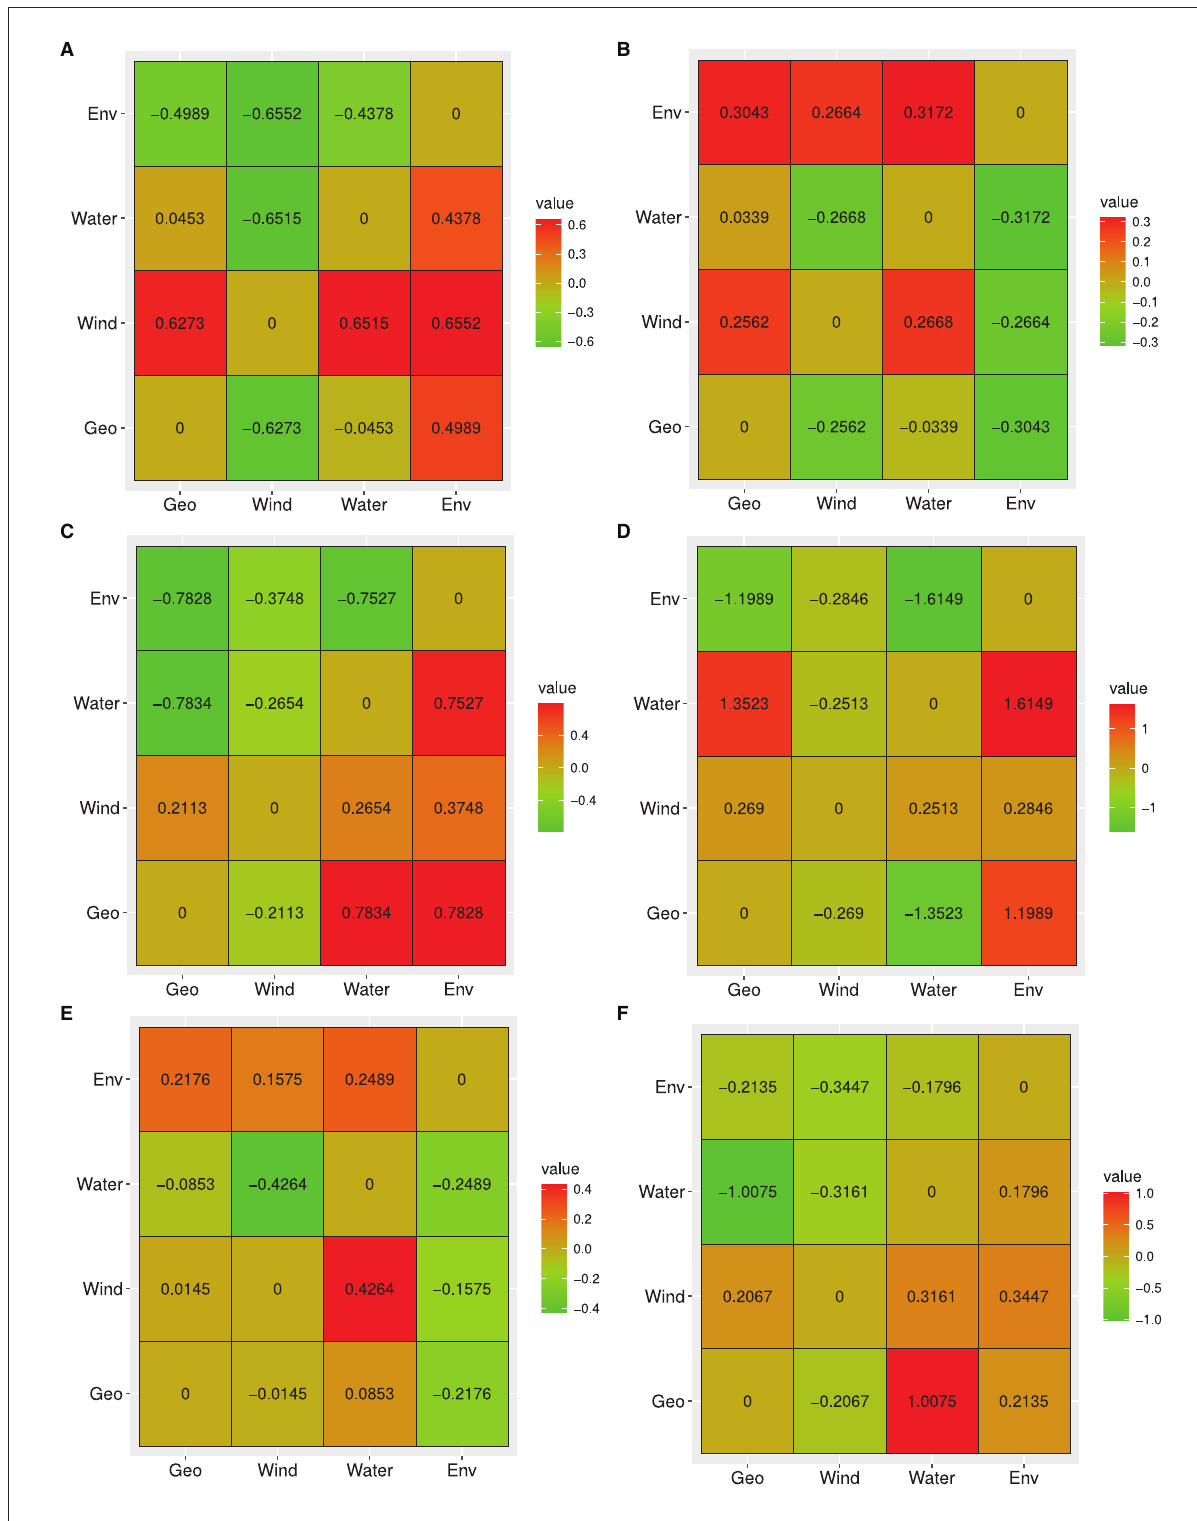
FIGURE4 Heat map for reciprocal causal model (RCM) values for the entire data set and each of the inferred clusters. (A) All population, (B) Heilongjiang River Basin, (C) Liaohe River Basin, (D) Huanghe River Basin, (E) Yangtze River Basin, (F) Pearl River Basin. Columns indicate test model and rows indicate alternative models. Each value represents the relative support for the test model. The best model has positive column values and negative/zero row